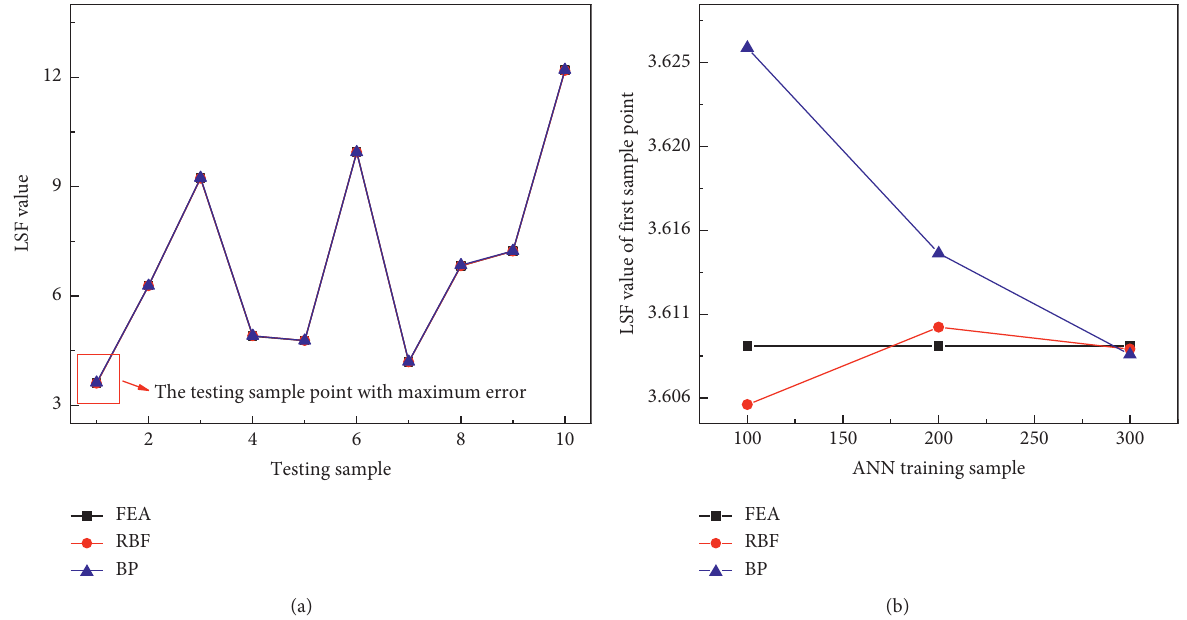
Figure 12: Comparison between the FEA values and the predicted LSF values by ANNs. (a) The LSF value at testing sample for an ANN sample size of 100. (b) The LSF value of the first testing sample point relative to change in the ANN sample data